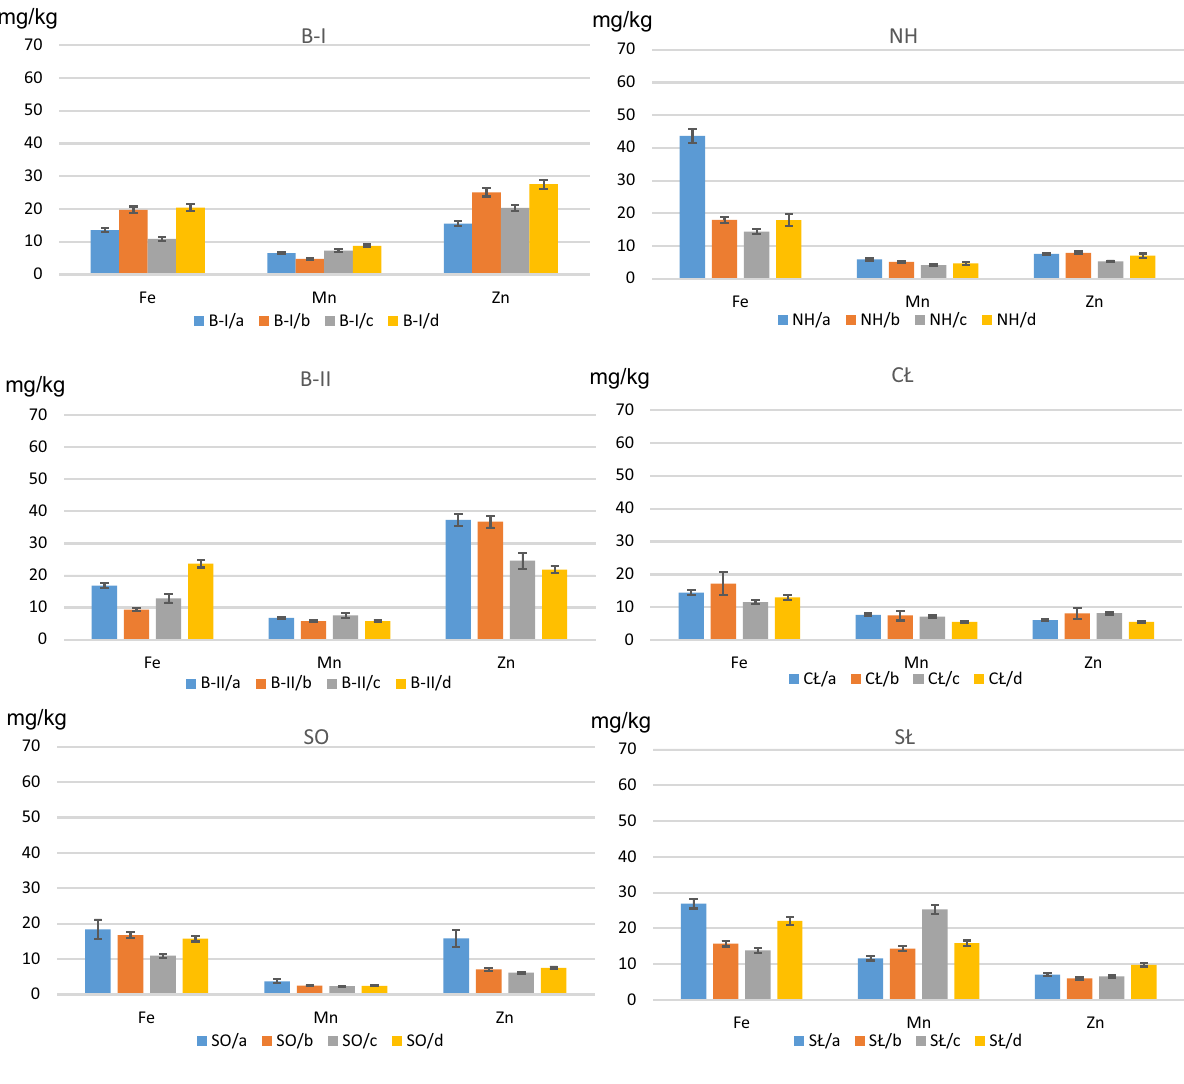
Figure 6. The content of Fe, Mn and Zn in lettuce, growing on: a —unfertilized soil, b —mix of straight fertilizers, c —multinutrient fertilizer and d —organic fertilizer. B-I, B-II—Bukowno region, SO—Sosnowiec, NH, CŁ—Nowa Huta region, SŁ—control